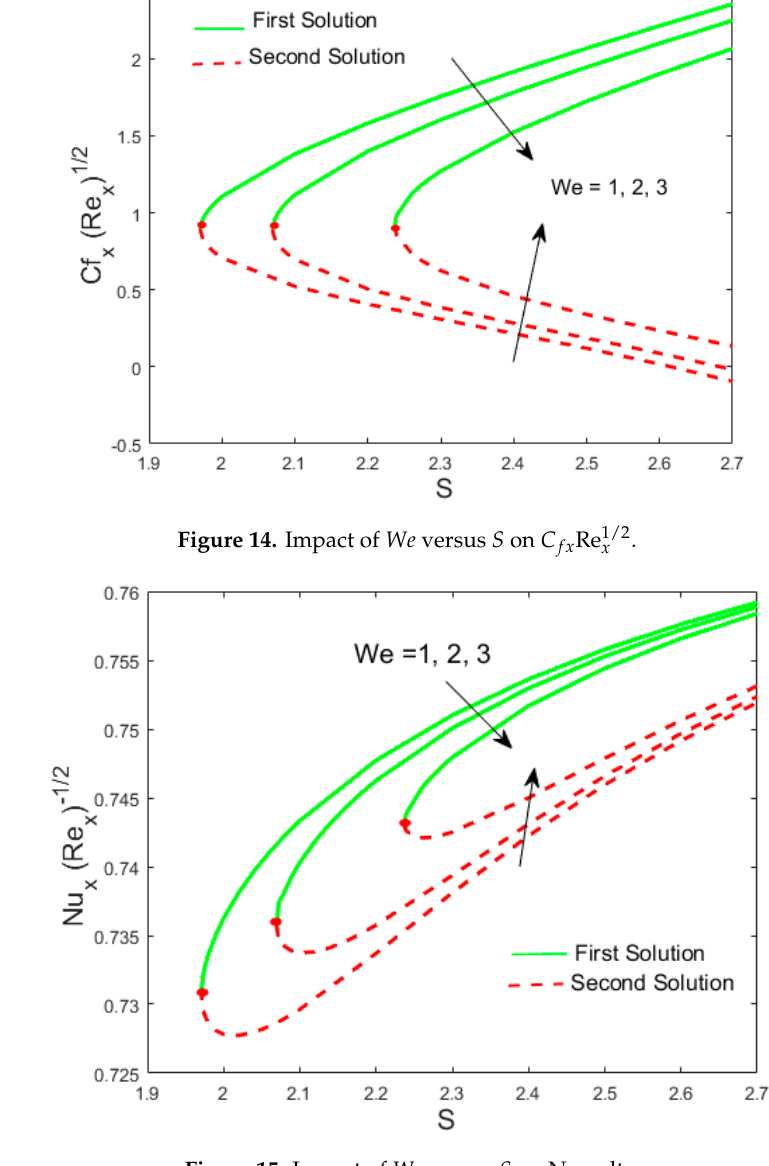
Figure 15. Impact of We versus S on Nusselt.